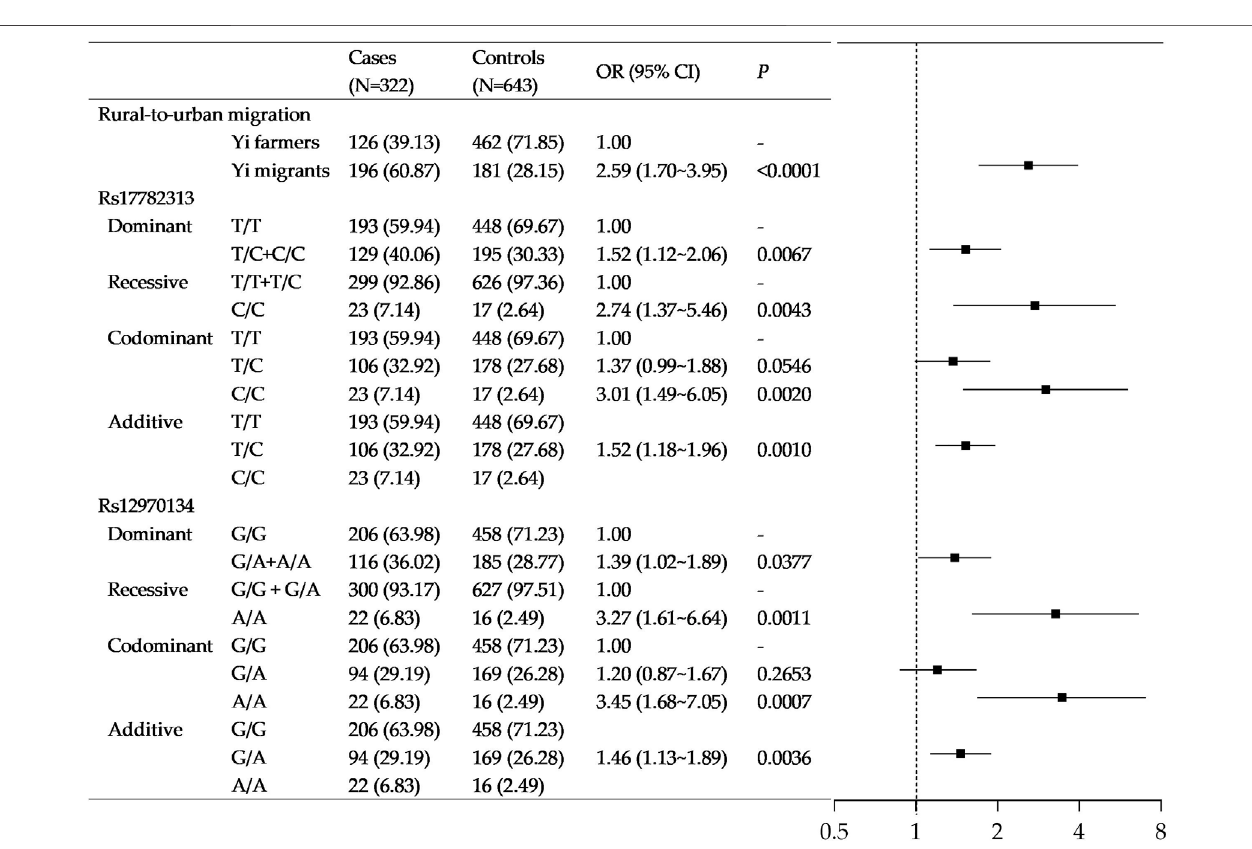
FIGURE 2 | Association of rural-to-urban migration and MC4R gene polymorphisms with obesity in Yi people. Note that the models were adjusted for age, sex, education, income, smoking status, drinking status, occupational physical activity, leisure-time exercise, and rural-to-urban migration.